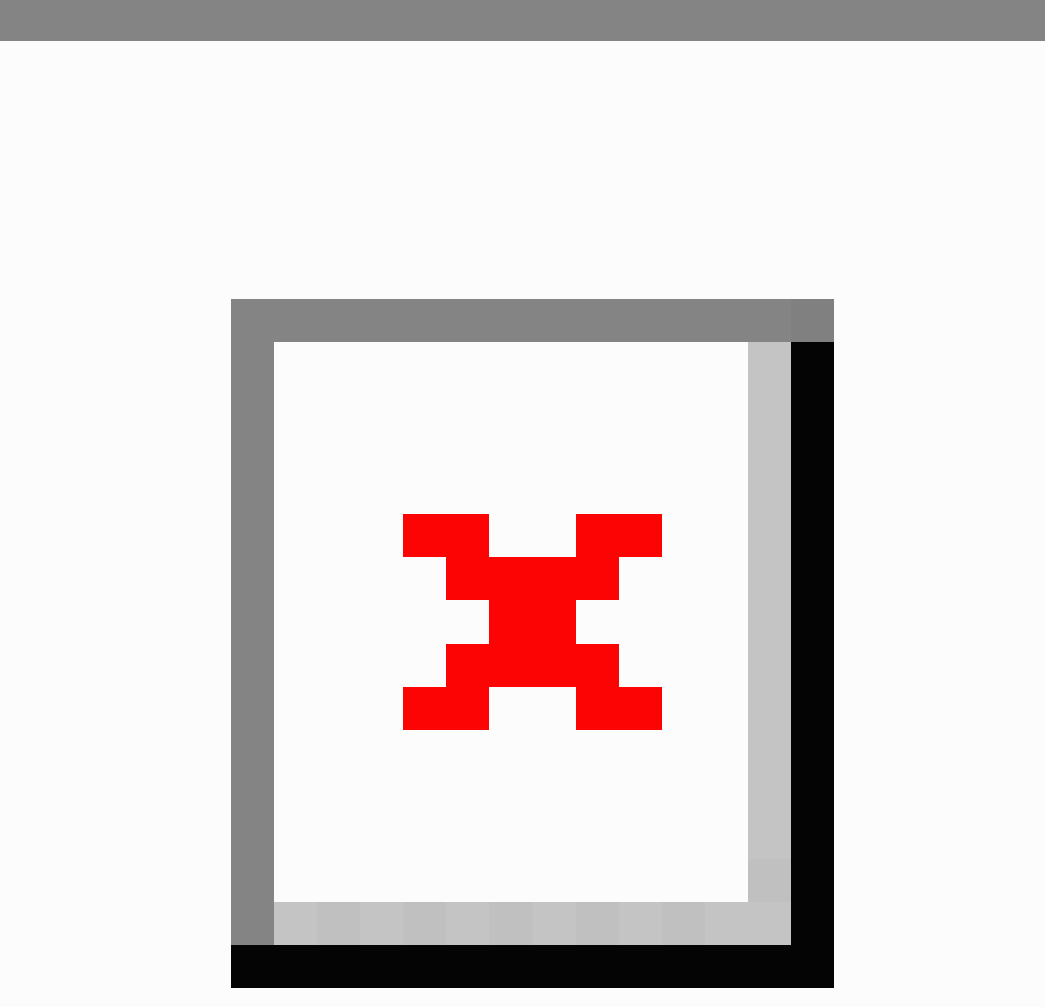
Figure 2. Bland-Altman plot of natural log transformed score showing the difference between IPAQ and SWA, plotted against the mean. Note: the lines represent the limits of agreement (95%) and average difference between the two